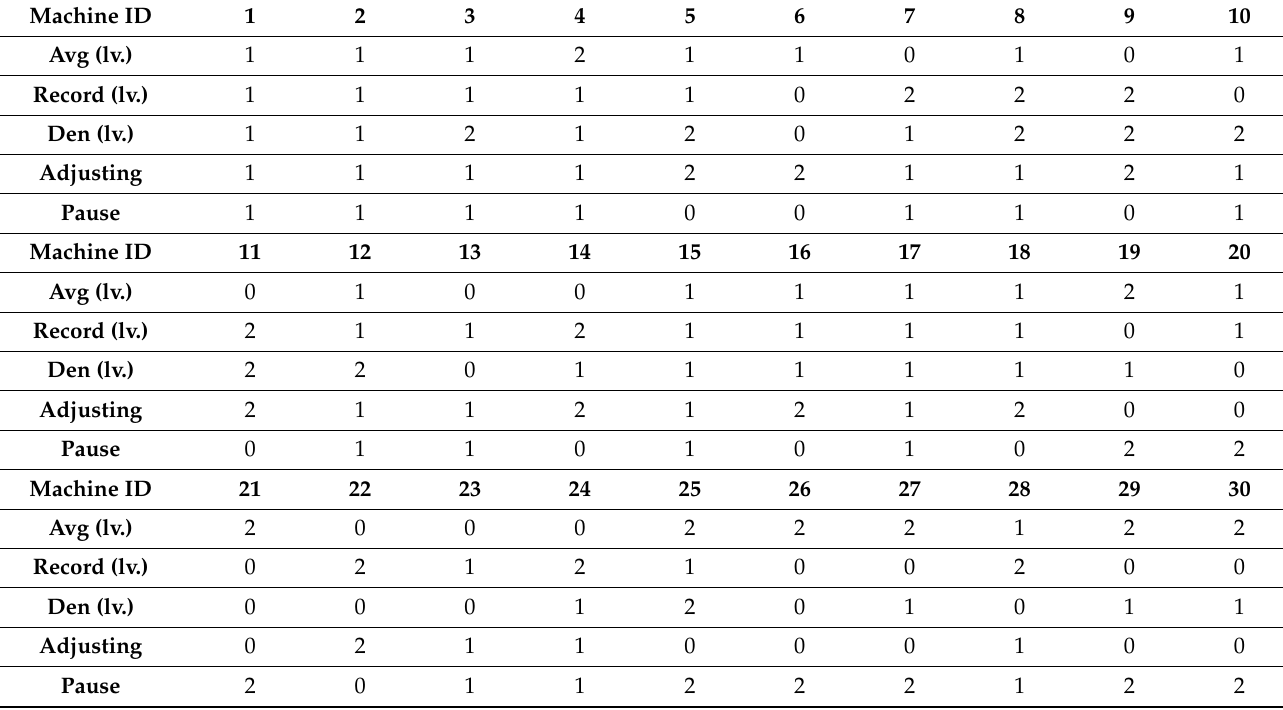
Table 3. Machine labelling results.